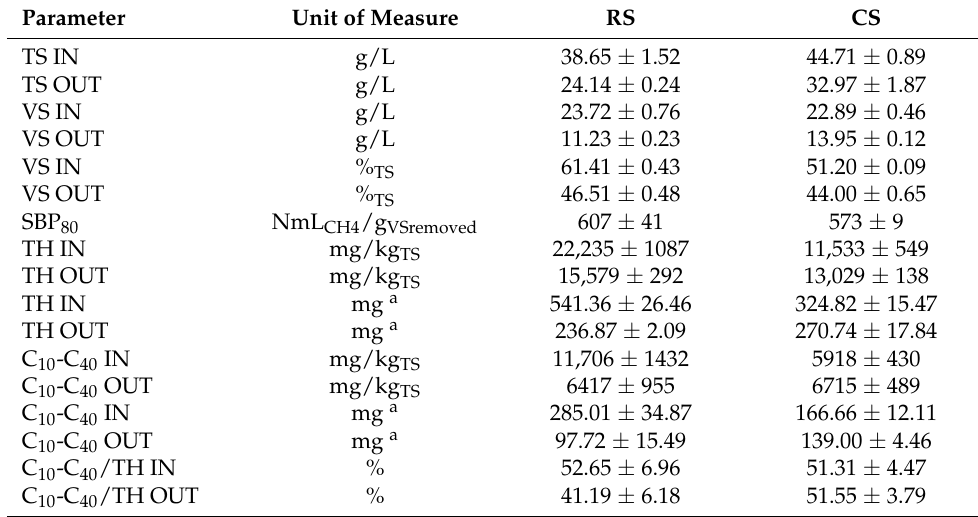
Table 1. Parameters of RS and CS measured before (IN) and after (OUT) AD.